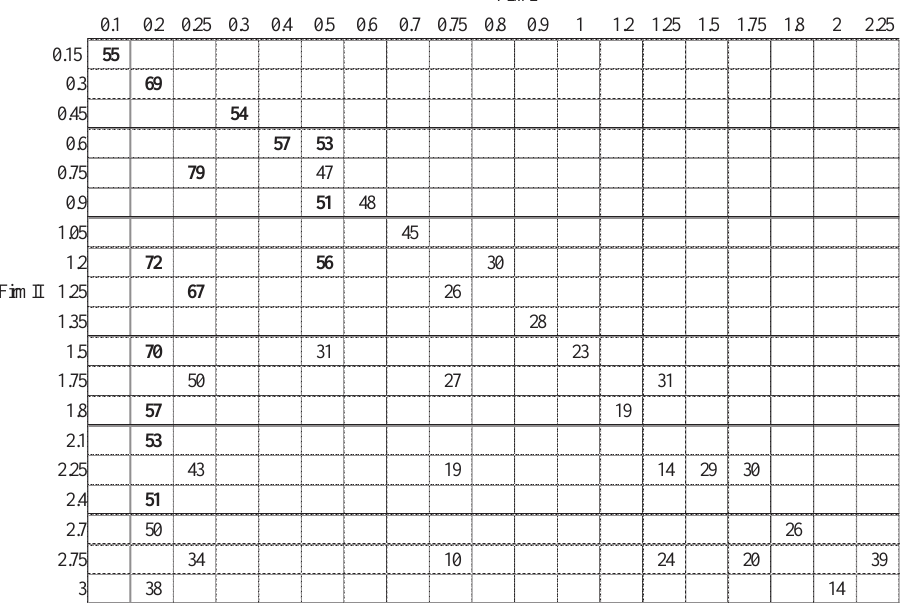
Figure 11. Market share of the high markup firm under different pairs of